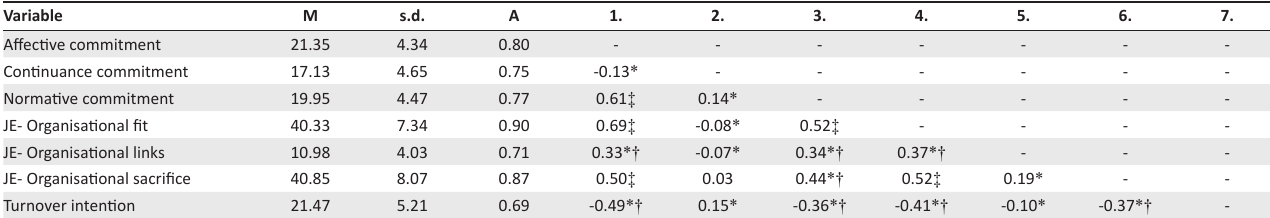
TABLE 2 : Descriptive statistics and Pearson correlation coefficient.